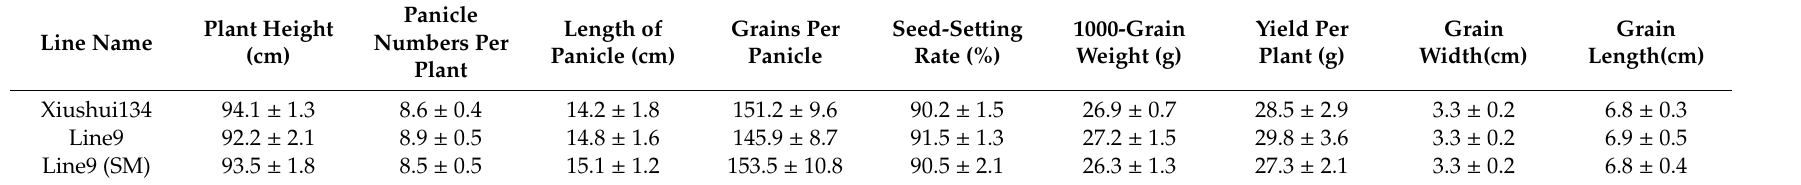
Table 3. Agronomic traits of the Xiushui134 and Line9